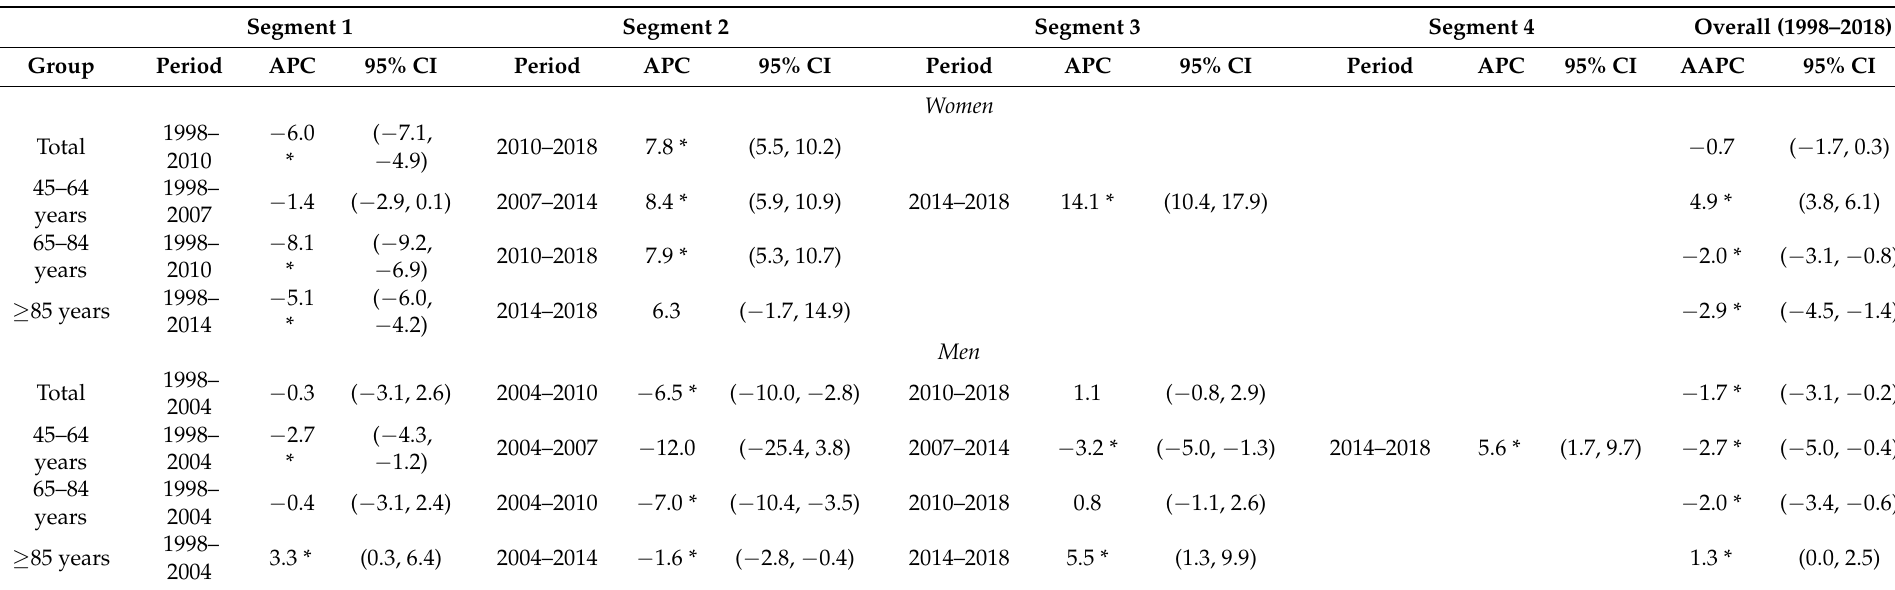
Table 1. Evolution of hospital admissions due to chronic obstructive pulmonary disease (COPD) in Spain, 1998 to 2018. Trend segments and annual percentage of change (APC) obtained by means of joinpoint regressions for age-standardised admission rates, by